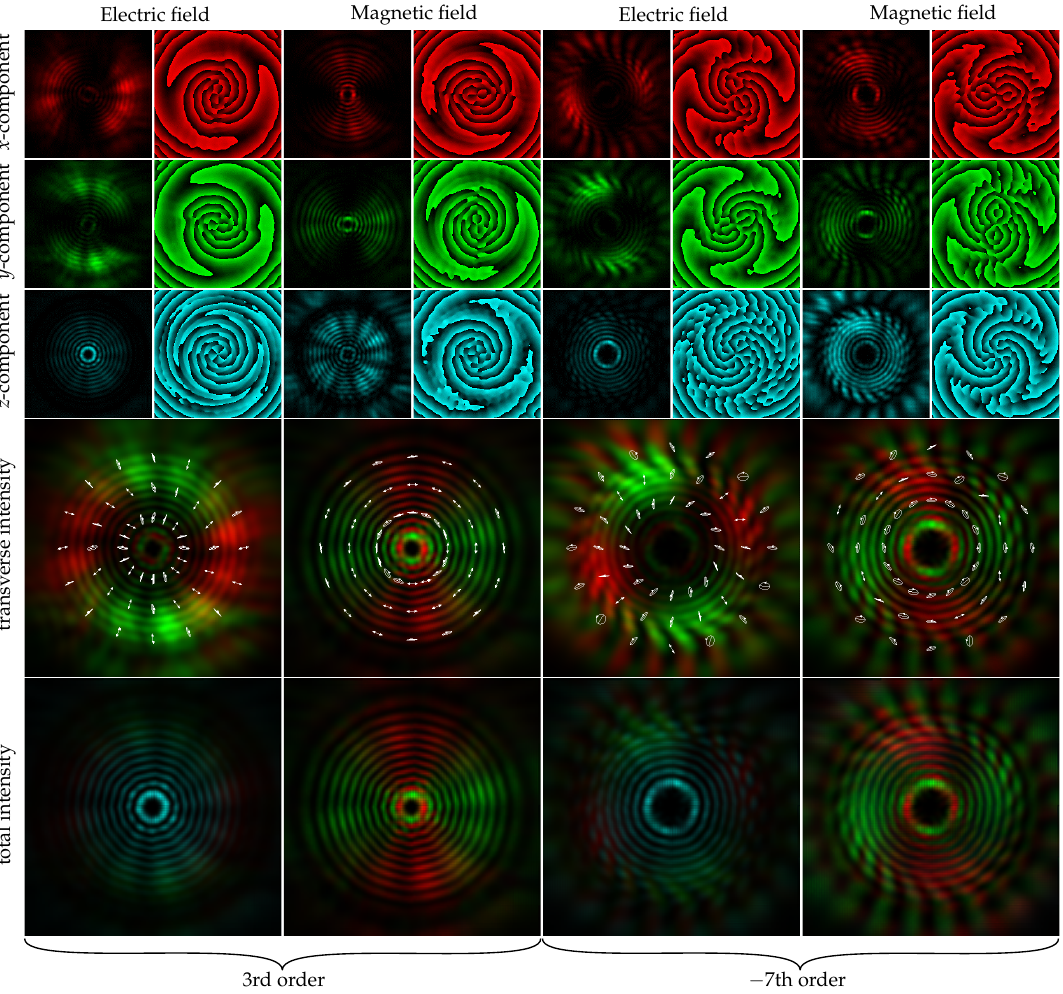
Figure 8. Distribution patterns of the emitted field in the near field. Size of the field plots is 26 µm × 26